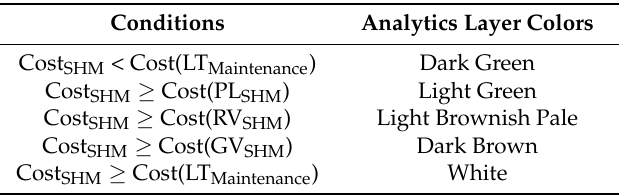
Table 1. SHM-UCM Layer